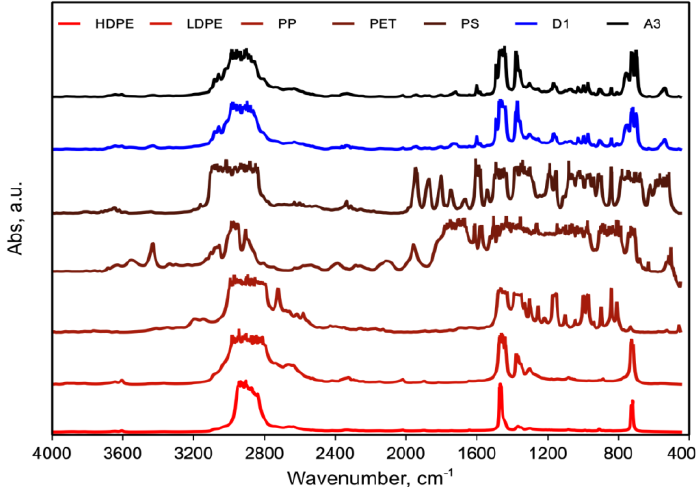
Figure 6. FTIR spectra of A3, D1 blend and individual polymers in blend: PE (HD and LD), PP, PET and PS. and